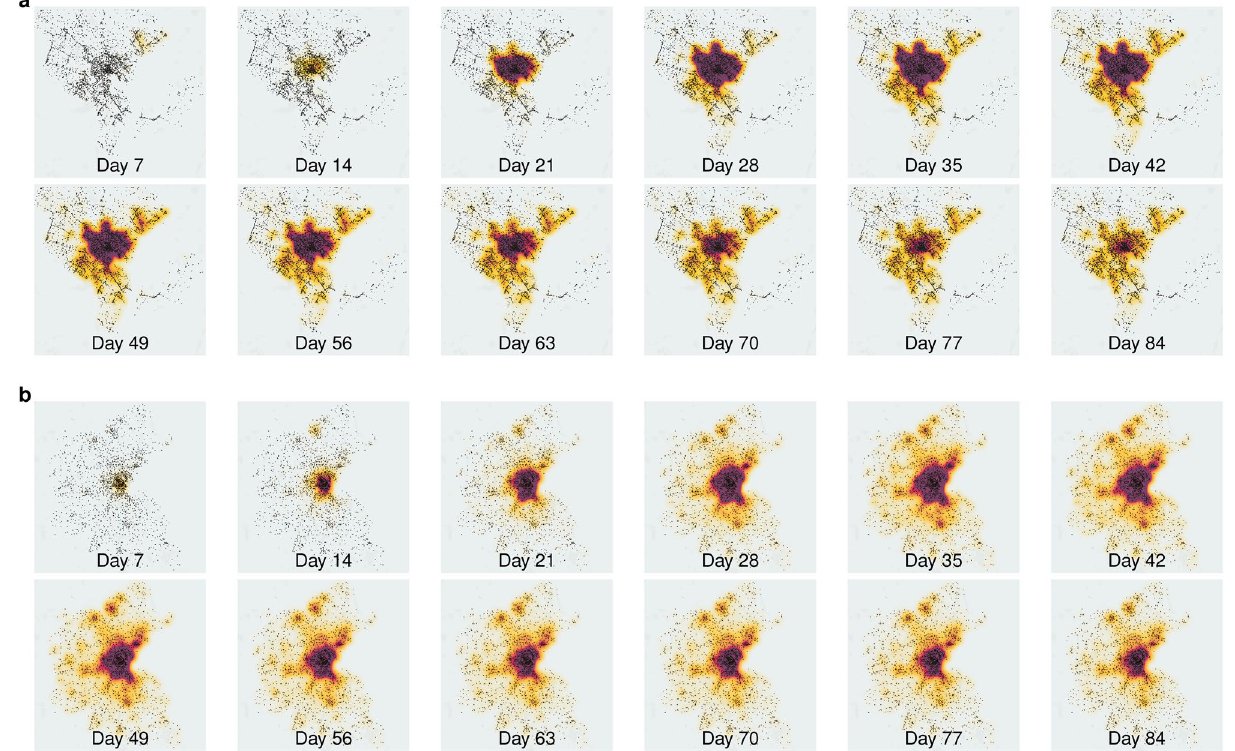
Figure 5. Spatial evolution of COVID-19. Heatmap of infected (exposed and infectious) individuals every seven days: ( a ) Auto Sprawl ; ( b ) Auto Innovative . As expected, the prevalence is greatest in city centers, regardless of the location of index cases. In Auto Innovative , the hubs are